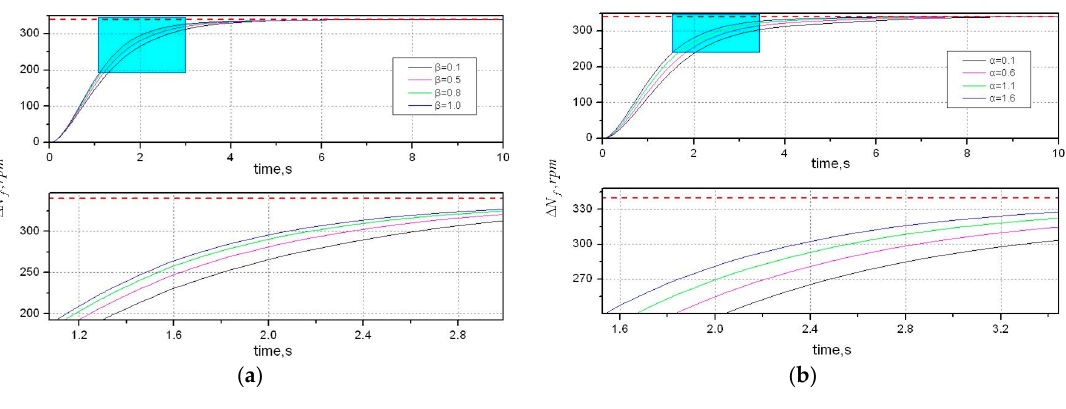
Figure 5. Limited output response with uncertainty in system parameters. ( a ) High-pressure turbine outlet temperature response; and ( b ) high-pressure compressor outlet static pressure response.